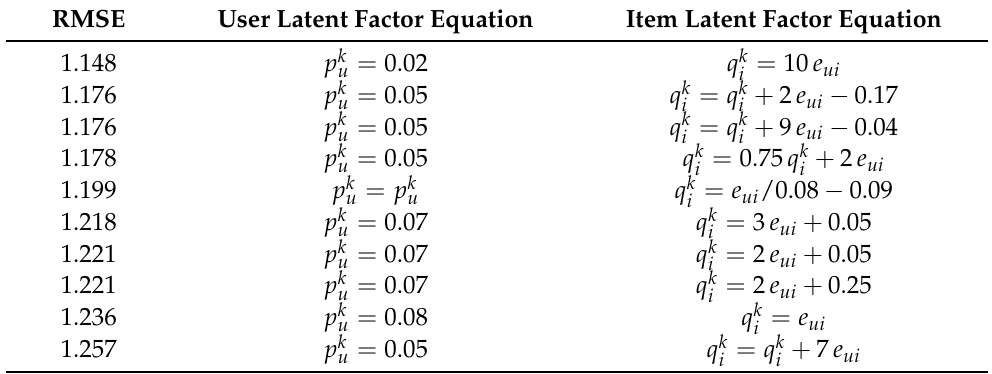
Table 8. Best programs obtained from 10 evolution runs of 150 generations on the CoMoDa dataset.